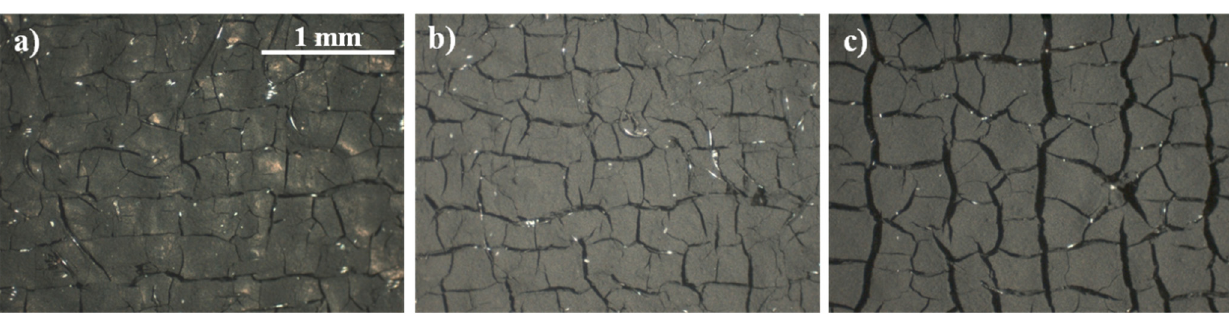
Figure 2. Optical microscope images of MPL surfaces: ( a ) GDM-PTFE; ( b ) GDM-PFPE-12; ( c ) GDM-PFPE-6